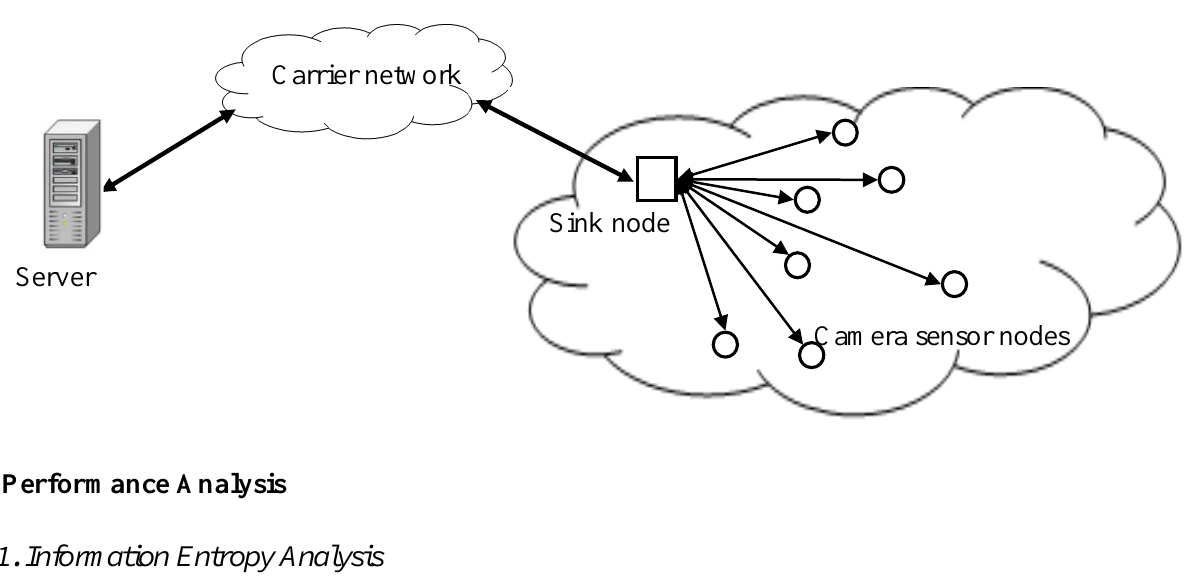
Figure 3. System architecture of the camera sensor